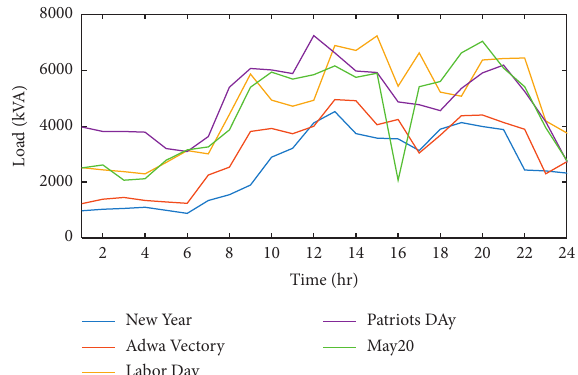
Figure 4: Hourly load profile of national holidays in 2017/18.